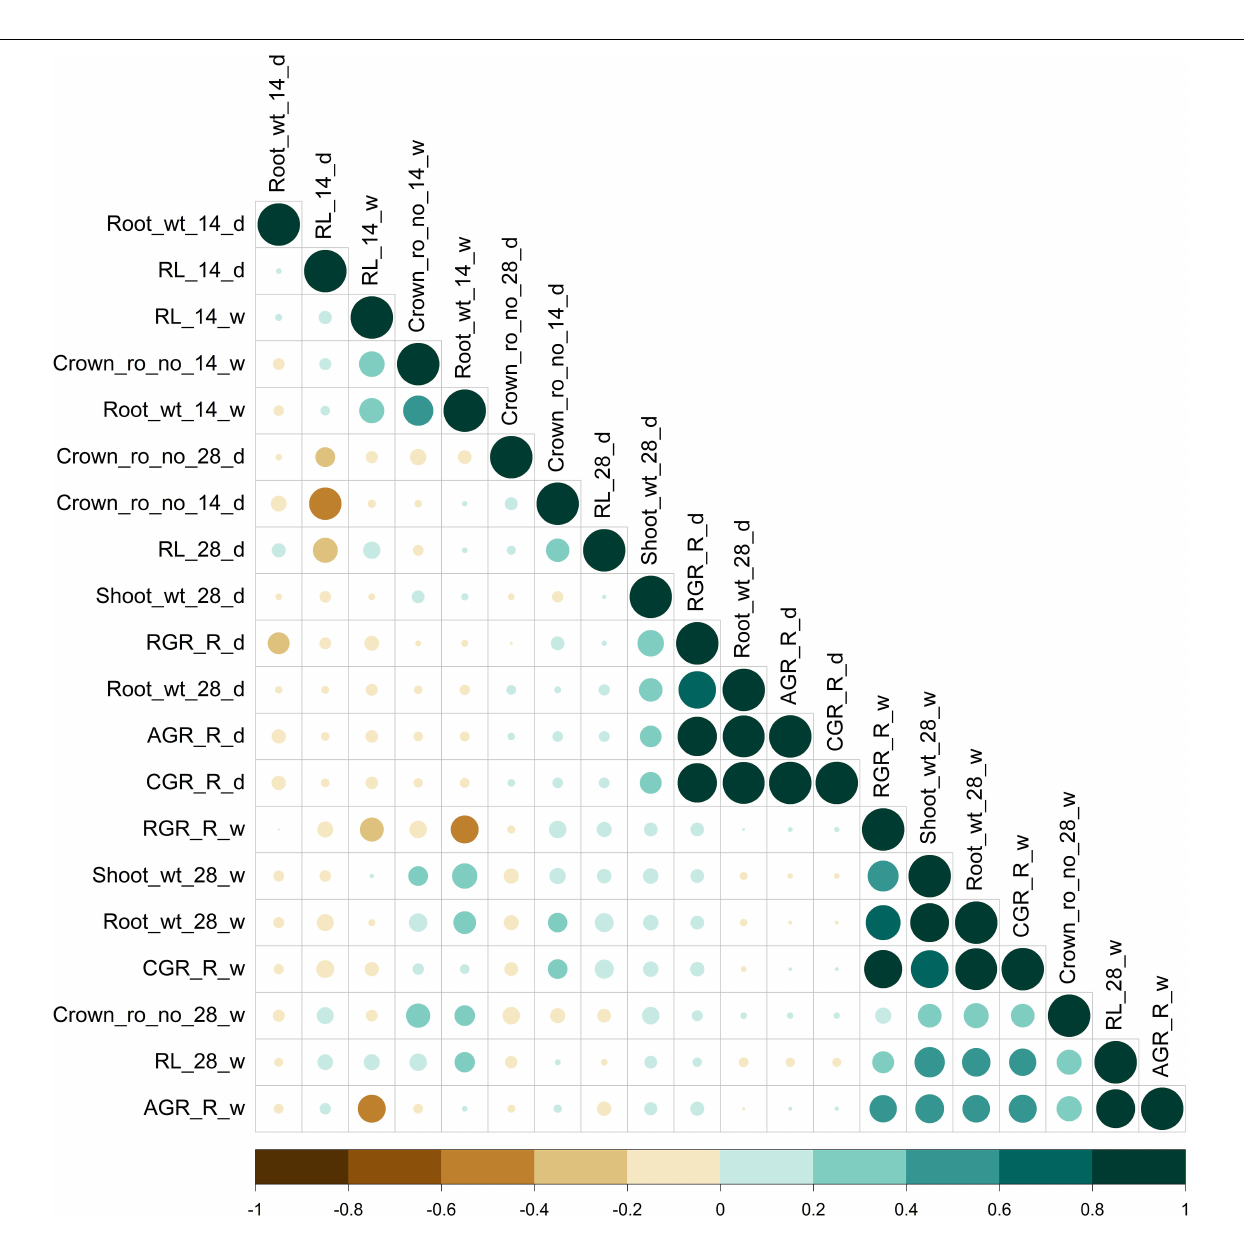
FIGURE 2 | Pearson correlation for root length, dry weight, crown root number, and root vigor index of dry (d) and wet (w) season under DSR condition. Color (green, positive correlation; brown, negative correlation) intensity and the size of the circle are proportional to the correlation